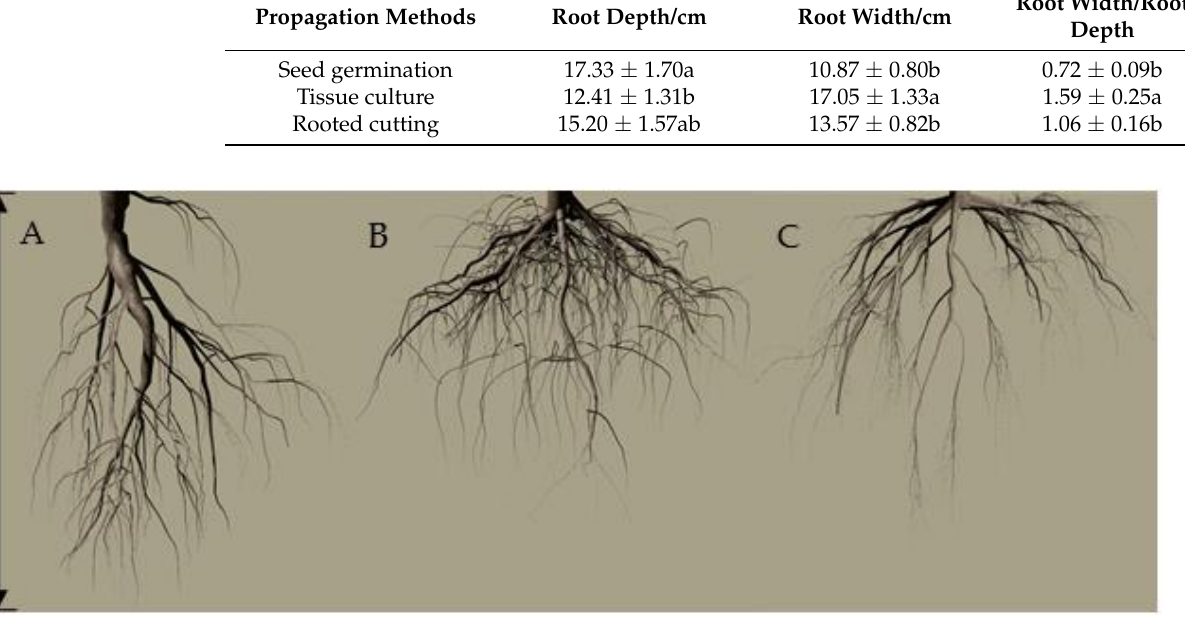
Figure 3. The root vertical distribution schematic diagram originated from seed germination ( A ), tissue culture ( B ), and rooted cutting ( C ).